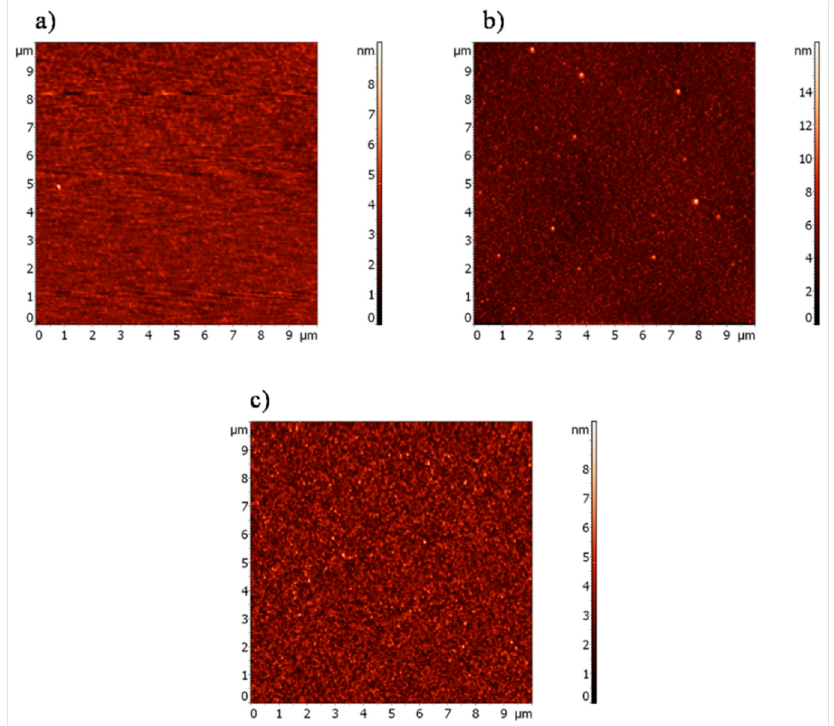
Figure 6. AFM images of ( a ) Ti-6Al-4V, ( b ) Ti-6Al-4V / PFDPA, and ( c ) Ti-6Al-4V / PFDA Figure 6 . AFM images of ( a ) Ti-6Al-4V, ( b ) Ti-6Al-4V/PFDPA, and ( c ) Ti-6Al-4V/PFDA surfaces.